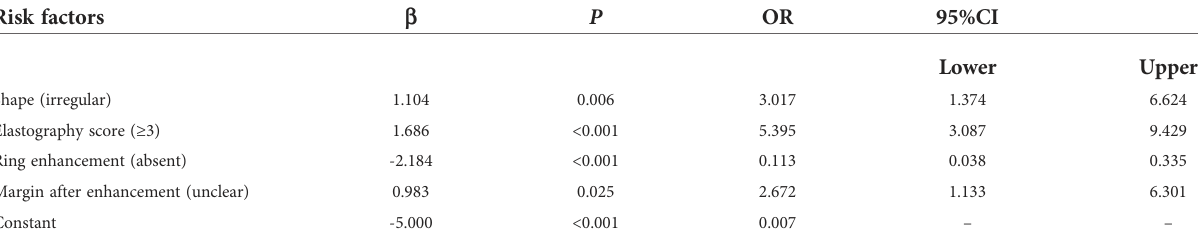
TABLE 6 Multivariate Logistic regression analysis of benign and malignant thyroid nodules in the training set.